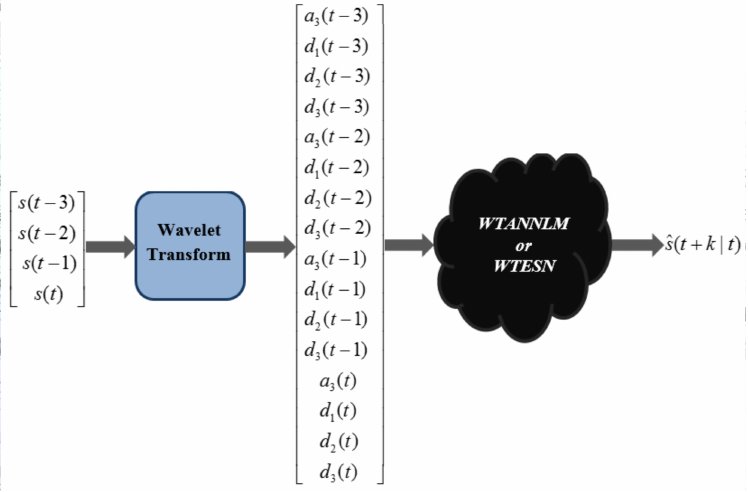
Figure 7. Illustration of models (WTANNLM or WTESN). Variables a and d are described in Section 2.5.